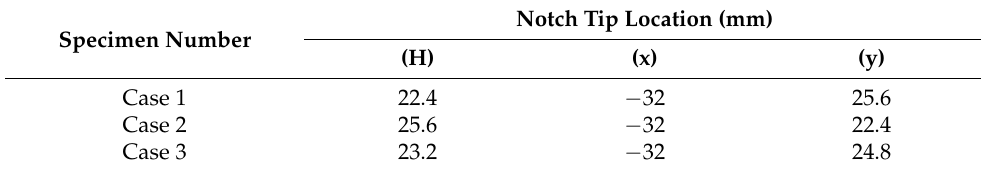
Figure 6. Tested specimens with different notch tip location, ( a ) case 1, ( b ) case 2, and ( c ) case 3. Table 2. Modified Compact tension Specimen (MCTS) notch tip location [50].